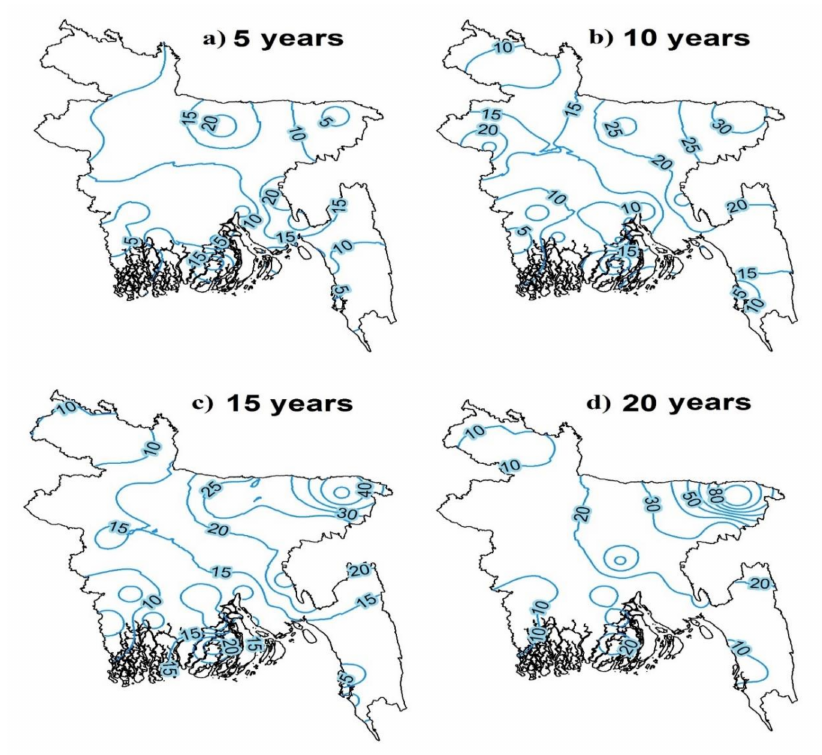
Figure 9. Probability of maximum annual TS days for di ff erent periods ( a ) 5 years; ( b ) 10 years; ( c ) 15 years; ( d ) 20 years in Bangladesh estimated using the data from 1975 to2016.